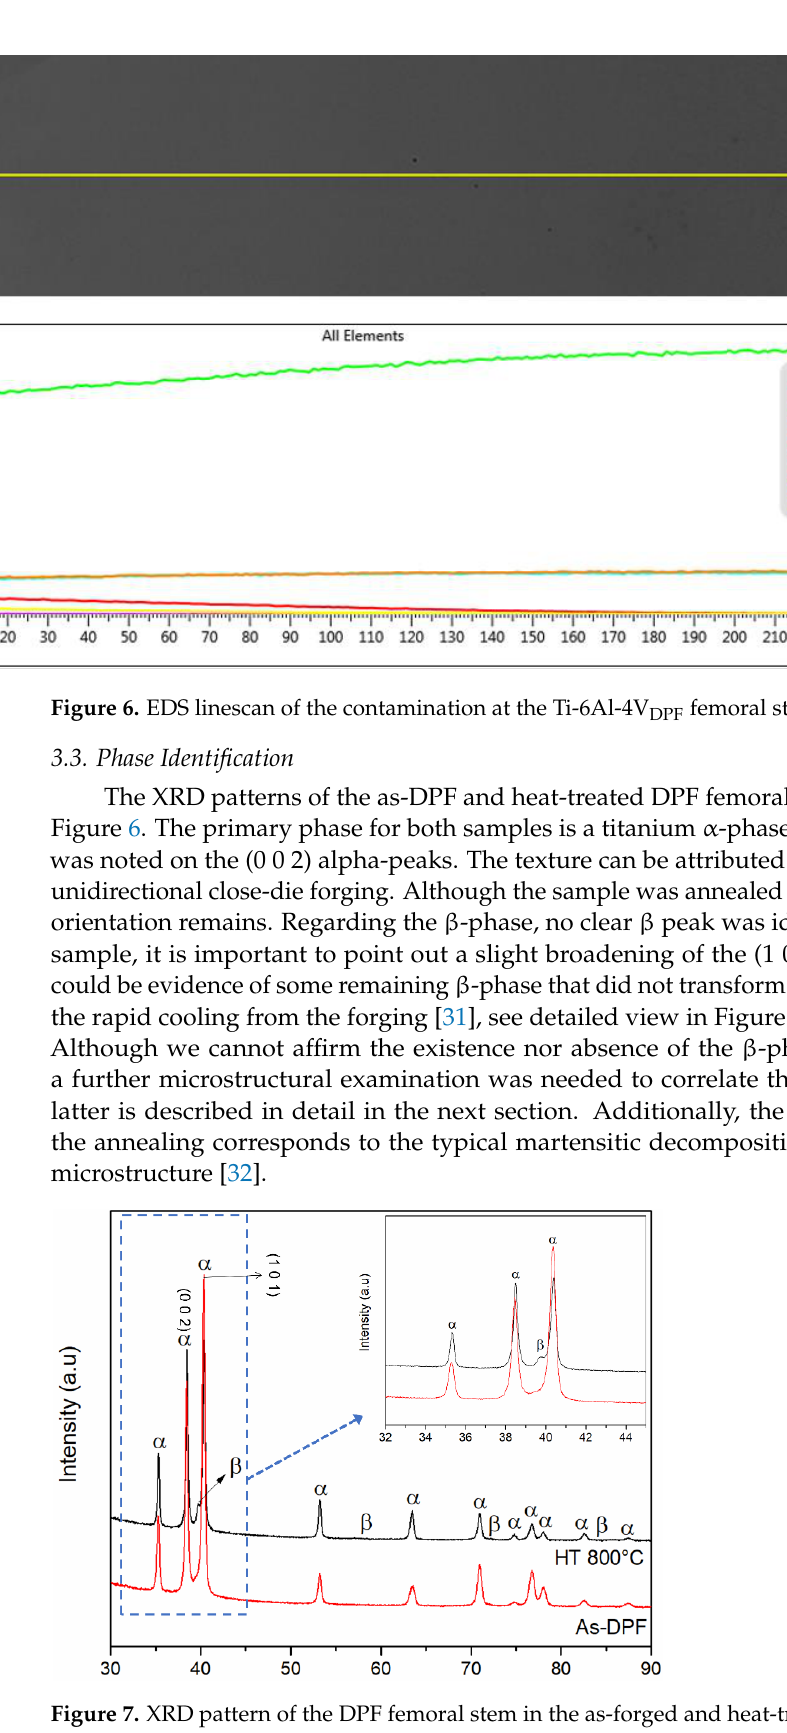
Figure 7. XRD pattern of the DPF femoral stem in the as-forged and heat-treated conditions.